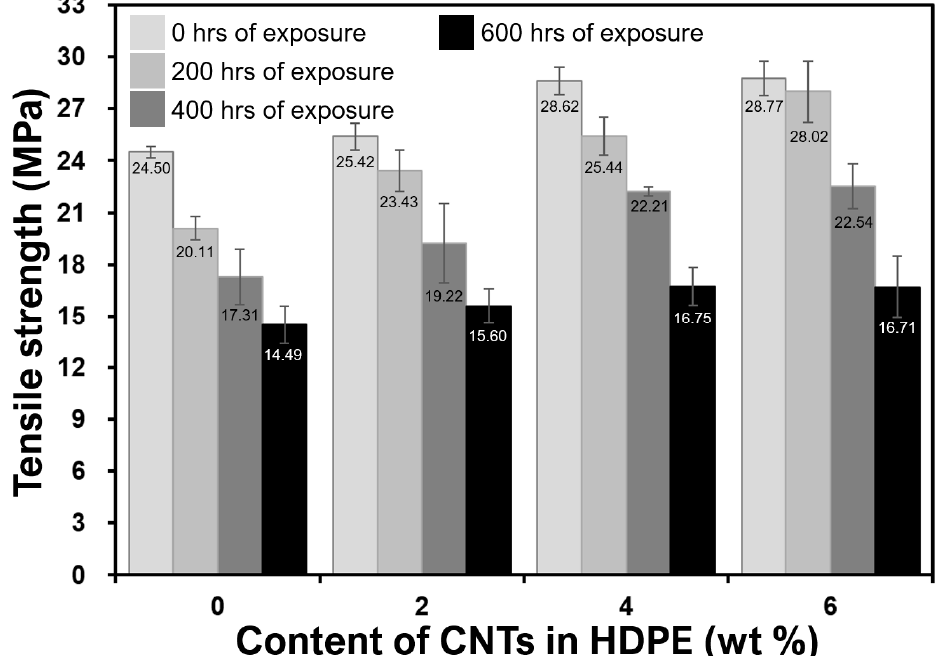
Figure 4. Effect of weathering on tensile strengths of monolithic and nanocomposite samples.